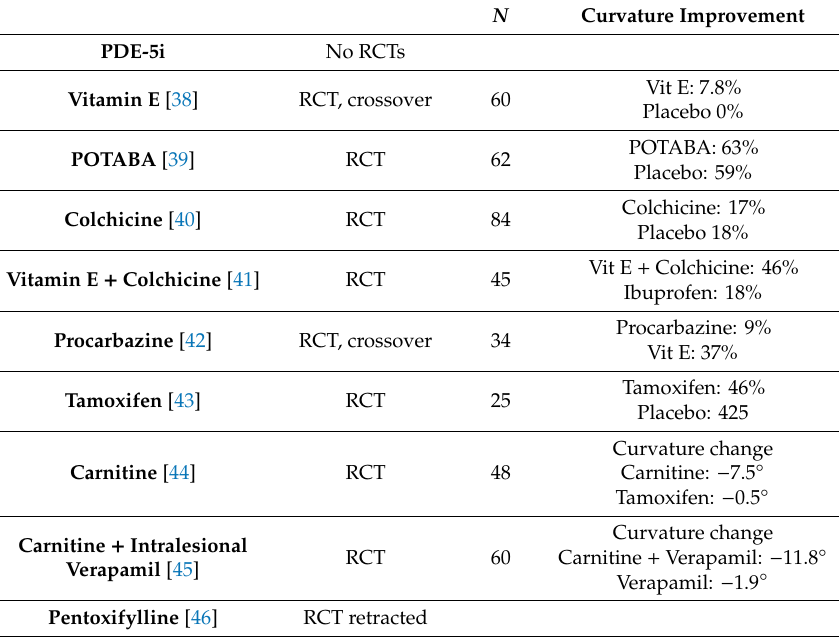
Table 6. Summary of findings from oral therapy randomized controlled trials on curvature.